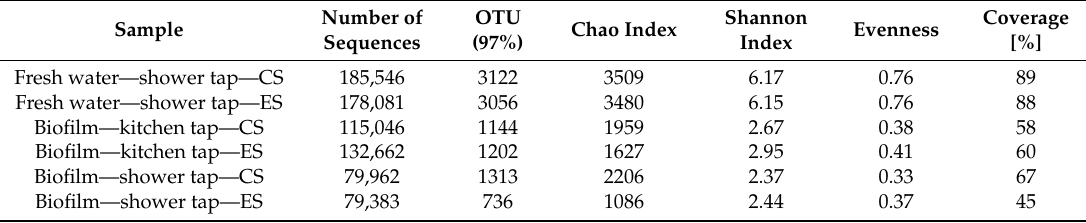
Table 2. Number of sequences, richness, diversity, evenness indexes and coverage for water samples and biofilm samples harvested from kitchen and shower taps in conventional (CS) and extended system